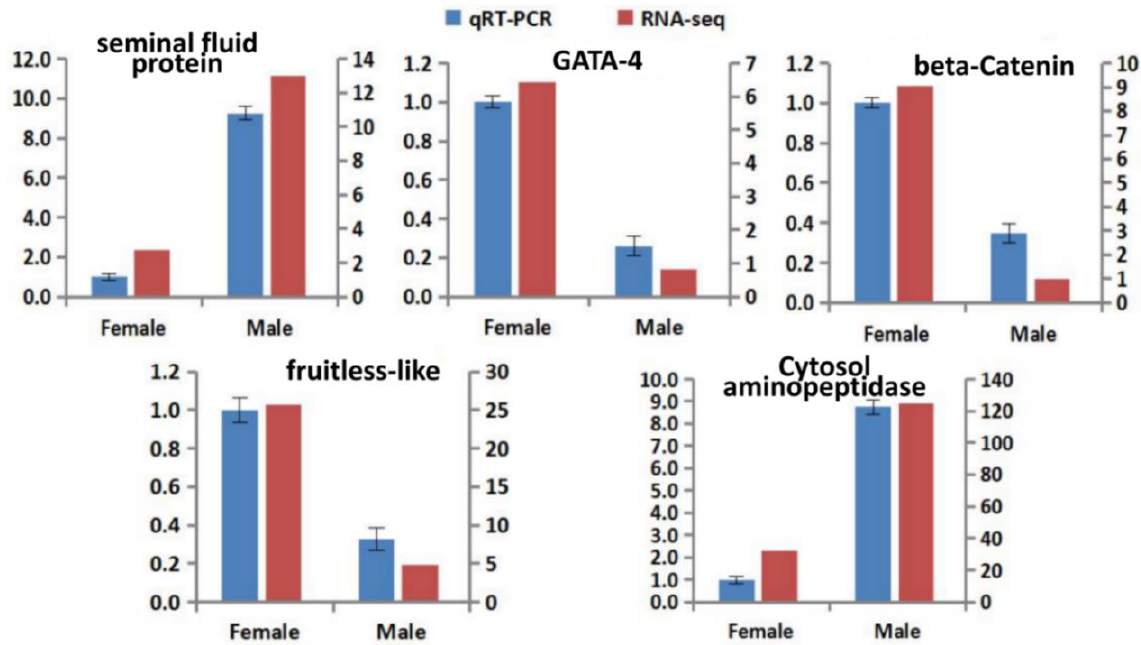
Figure 10. Expression levels of the genes given by high-throughput sequencing and qRT-PCR. The Y axis (left) indicates the relative expression by qRT-PCR, and the Y axis (right) indicates the FPKM caculated by RNA-seq.